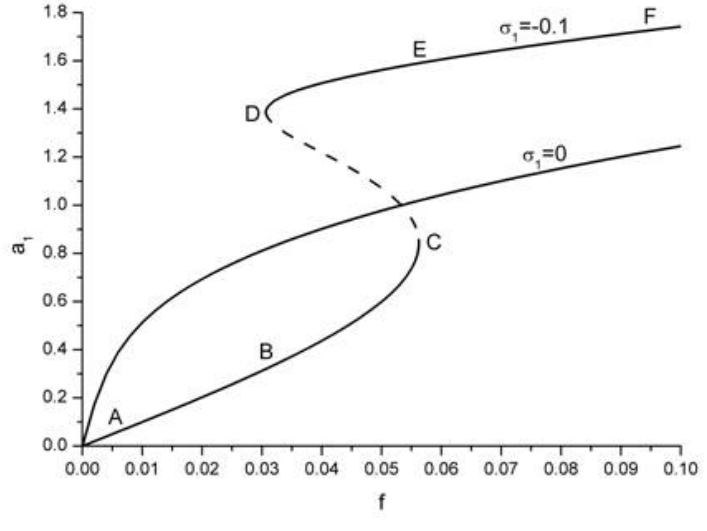
Fig. 8. Force-response curves for the open-loop case.